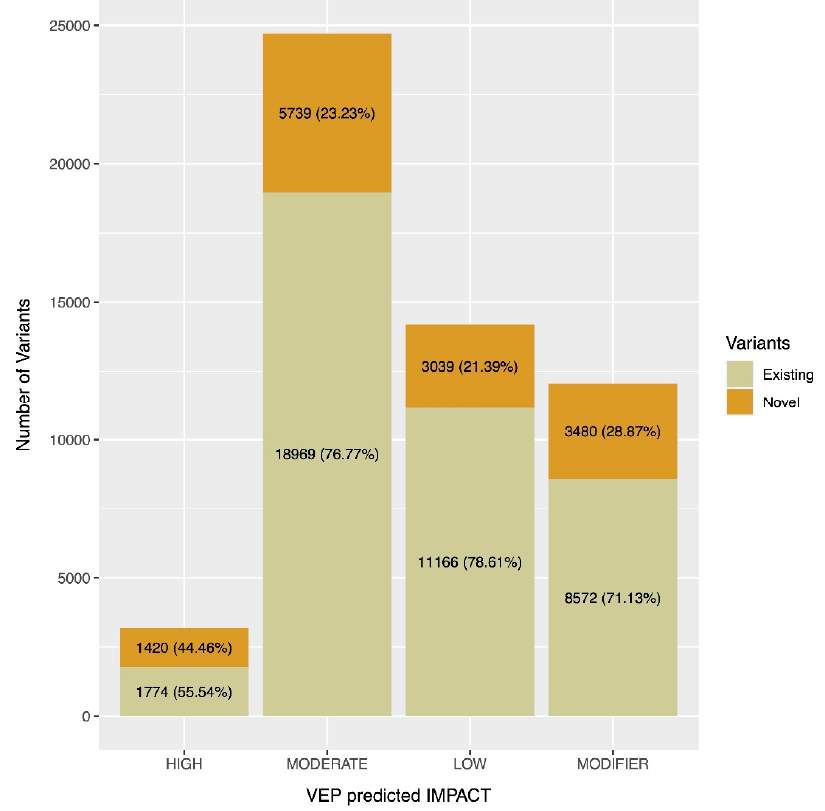
Figure 2. Number of novel and previously known PGx variants within 50,726 DiscovEHR exomes binned in 4 categories according to their VEP impact (‘HIGH,’ ‘MODERATE,’ ‘LOW,’ ‘MODIFIER’). The percentages of novel and existing variants within each VEP impact category are also